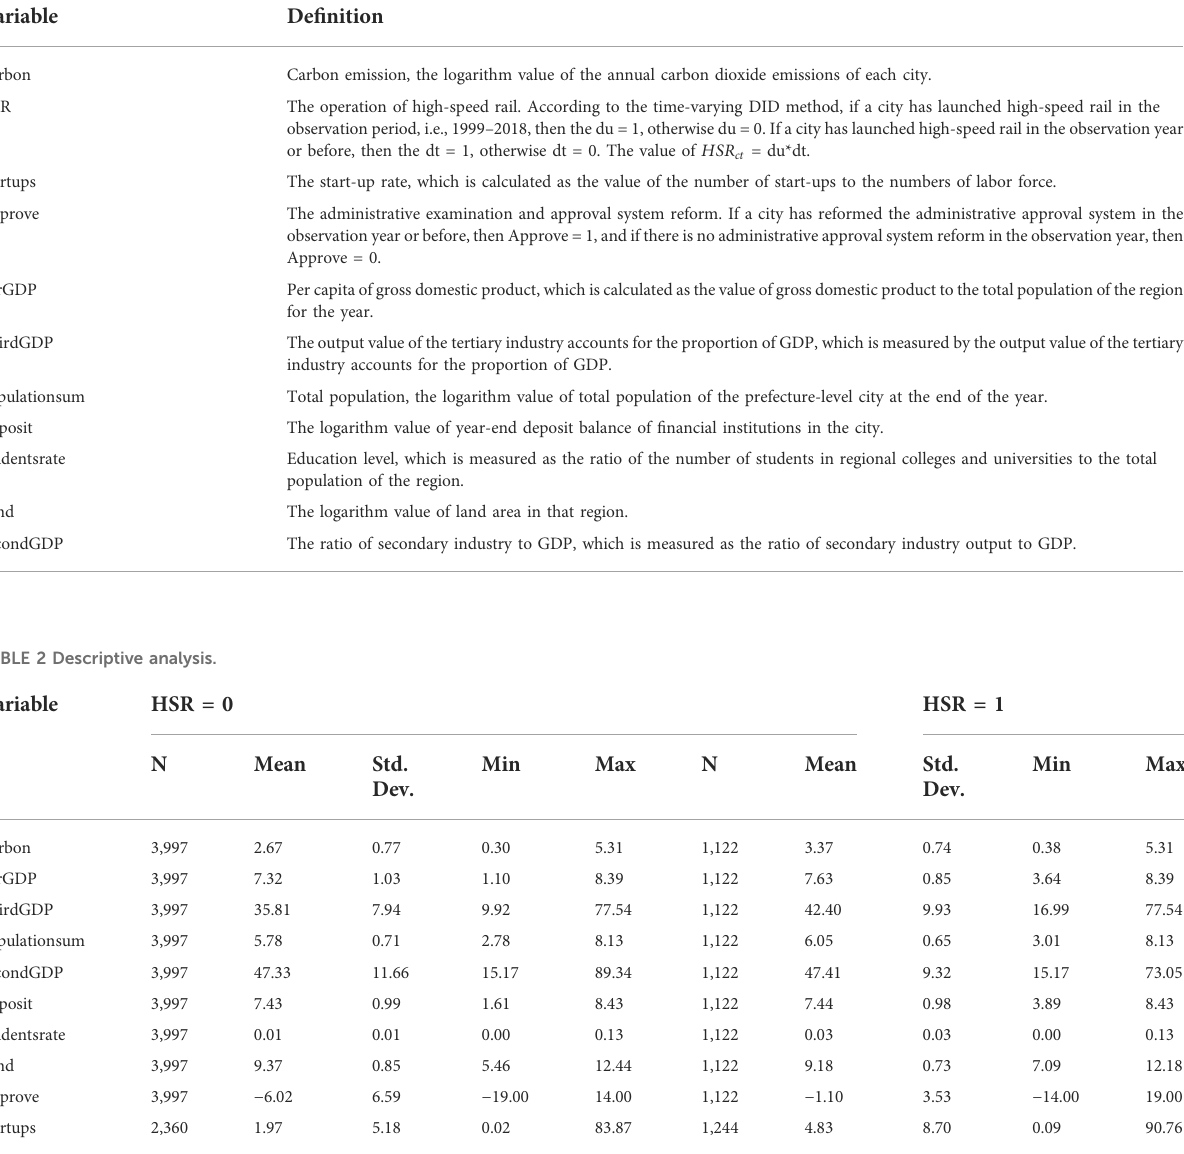
TABLE 1 De fi nitions of variables.